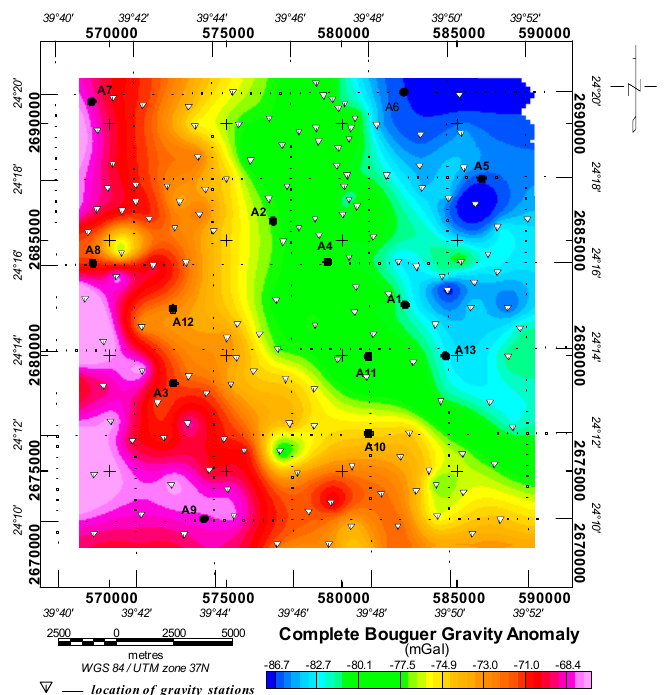
Figure 4. The complete Bouguer gravity anomaly map of the study region. The inverted white triangles, symbolize the gravity measurement stations within the study area. The “A” labels with accompanying numbers represent the Al–Madinah Al–Munawwarah region. The numbers used here designate the various locations within the Al–Madinah Al–Munawwarah